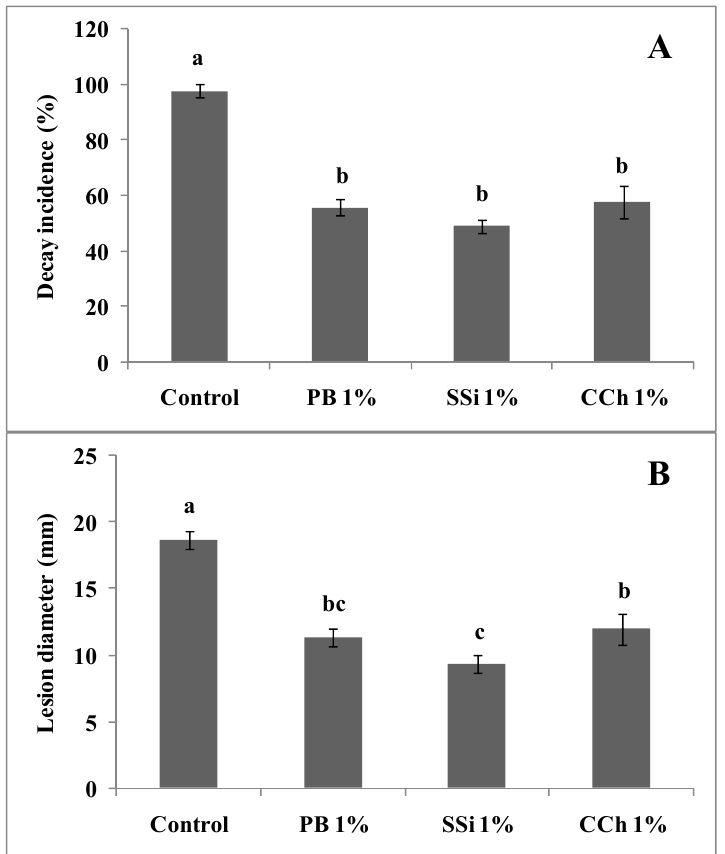
Figure 2. Decay incidence ( A ) and lesion diameter ( B ) of indirect antifungal activity of PB, SSi and CCh at 1%. Salt solution and pathogen were added to separate wounds. Columns marked with the same letters are not significantly different by Fisher’s protected LSD test at p ≤ 0.05.